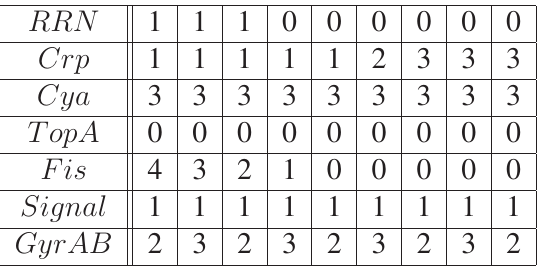
Figure 6: Simulating the switch from exponential to stationary phase in E. coli